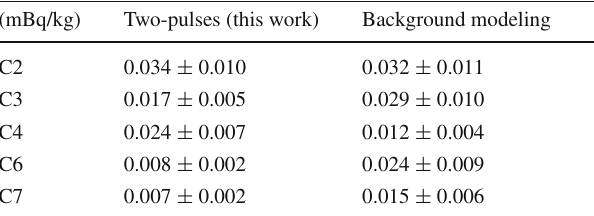
Table 1 228 Ra contamination in the COSINE-100 crystals measured using the two-pulse events at 6.28keV. These measurements are com- pared with the fit result from the background modeling of the COSINE-